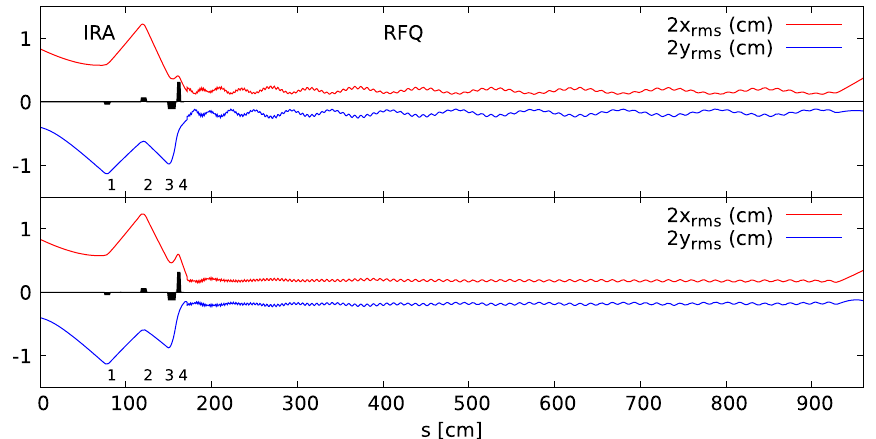
FIG. 7. Transverse beam envelopes for ISAC-RFQ injection. The top figure shows the original IRA-RFQ tune, computed 1997, prior to RFQ installation. The IRA electrostatic quadrupoles are numbered on both plots and their relative strength functions are shown in black, in arbitrary units. In the bottom figure, the RFQ injection has been recomputed using TRANSOPTR ’ s RFQ subroutine, providing an optimized match through the